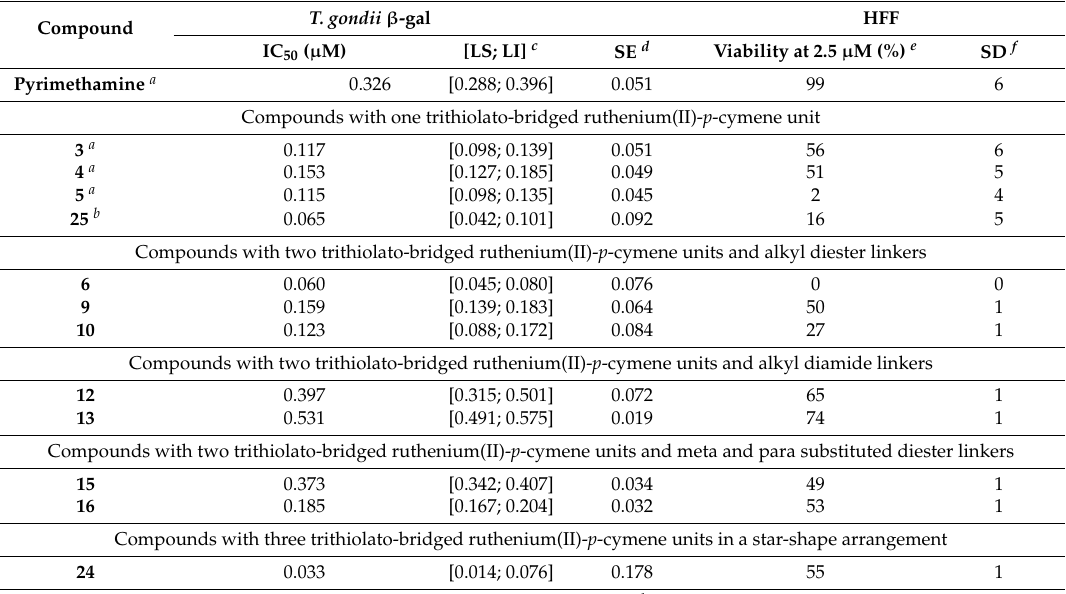
Table 1. Half maximal inhibitory concentration (IC 50 ) values ( µ M) on T. gondii β -gal for twelve selected compounds and pyrimethamine (used as standard), and their e ff ect at 2.5 µ M on HFF viability. T. gondii β -gal HFF Compound IC 50 ( µ M) [LS; LI] c SE d Viability at 2.5 µ M (%) e SD f Pyrimethamine a 0.326 [0.288; 0.396]